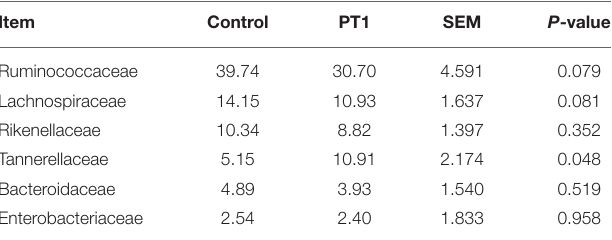
TABLE 7 | The dominant flora at the Family level.